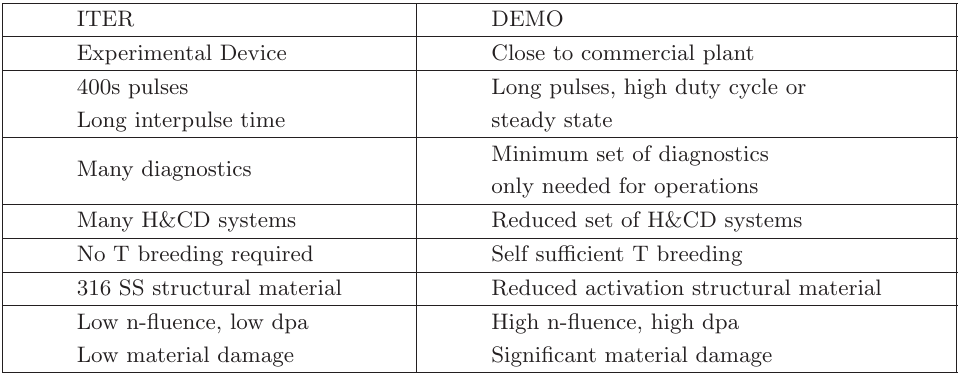
Table IV. – Main differences between ITER and